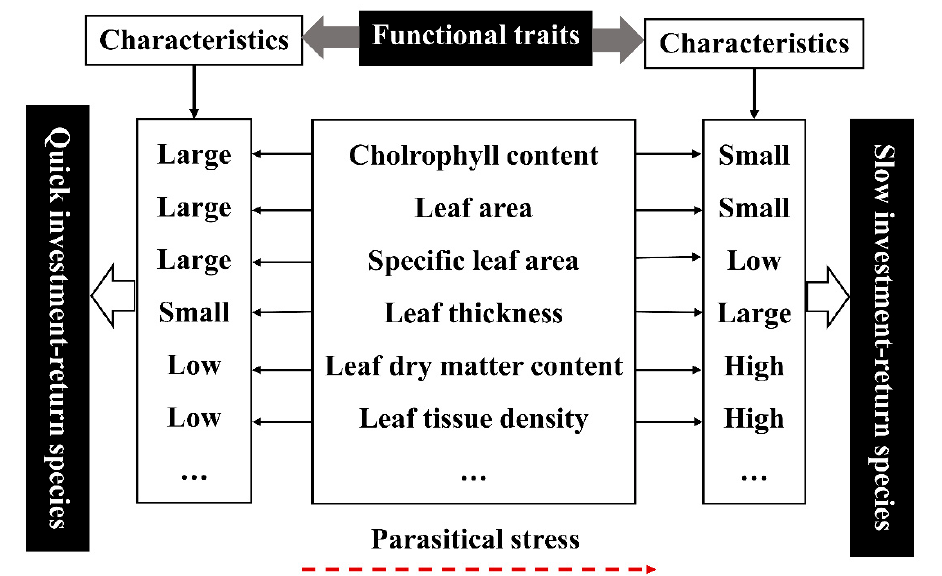
Figure 9. Conceptual illustration of leaf economics spectrum [36,62].